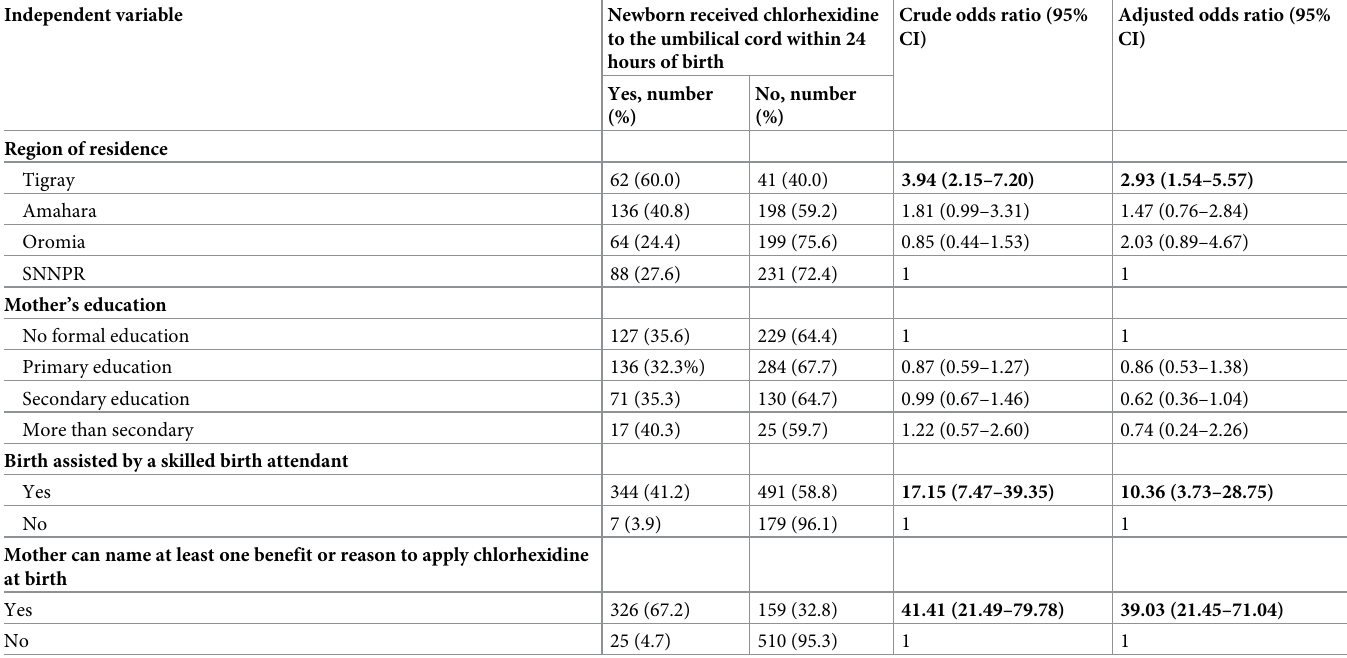
Table 4. Determinants of chlorhexidine cord care of neonates, four regions of Ethiopia, Feb 2020. Independent